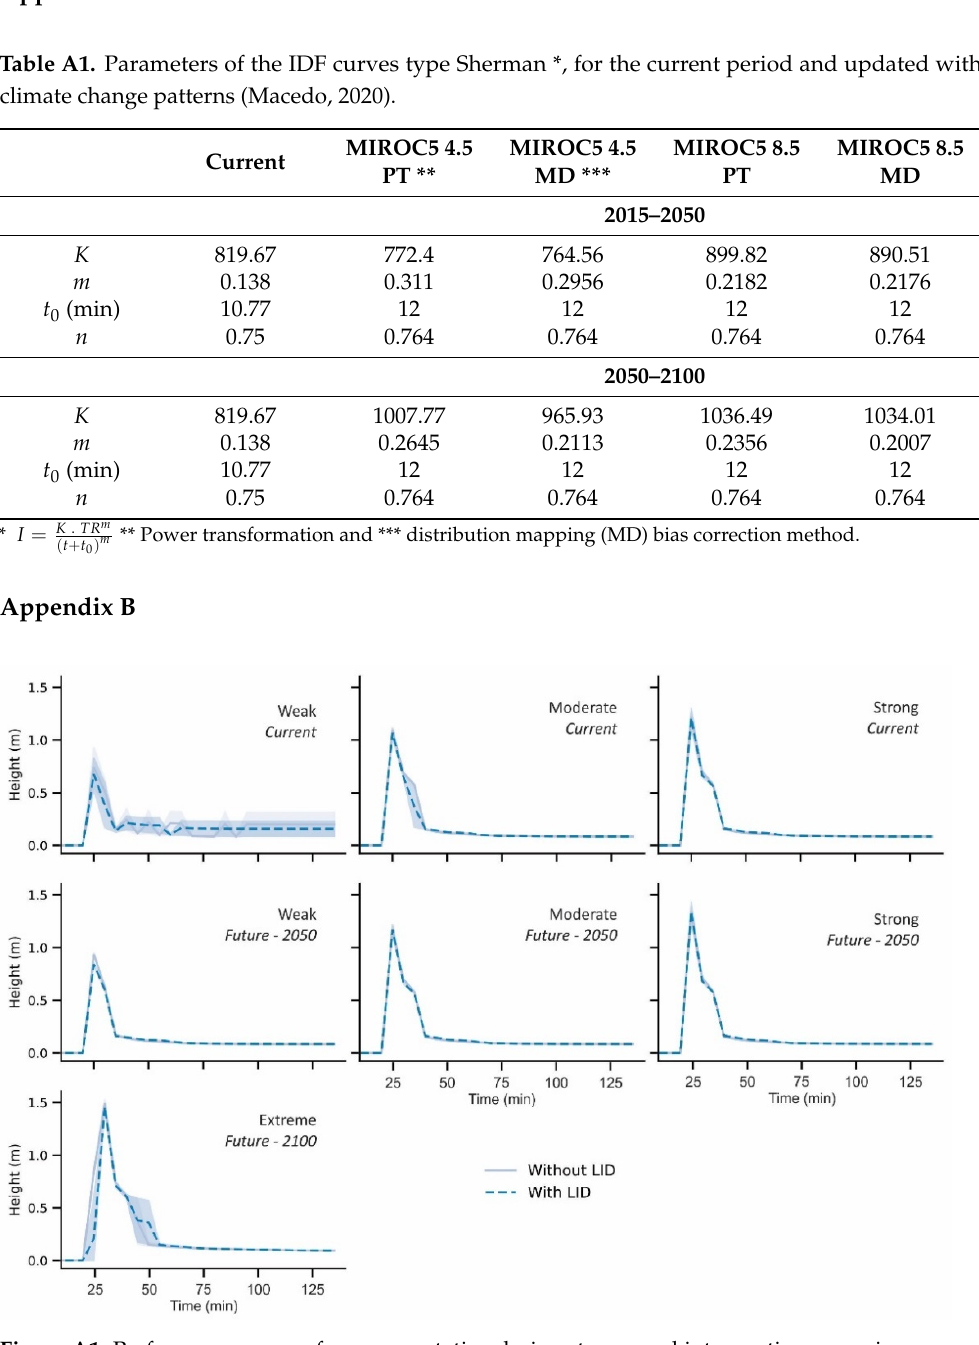
Figure A1. Performance curves for representative design storms and intervention scenarios.